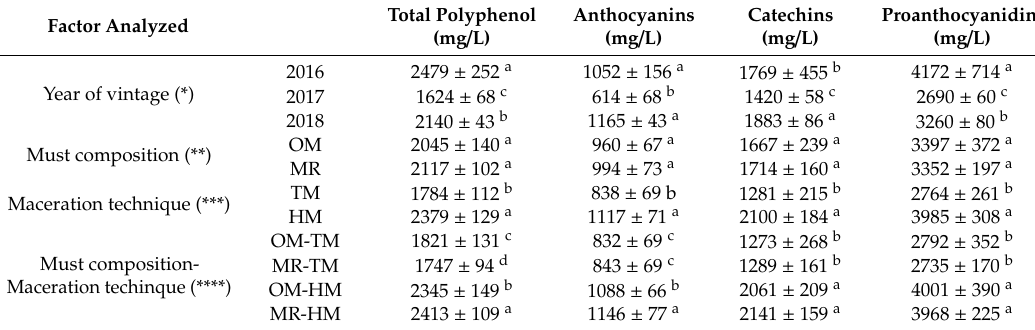
Table 2. Polyphenolic composition of the